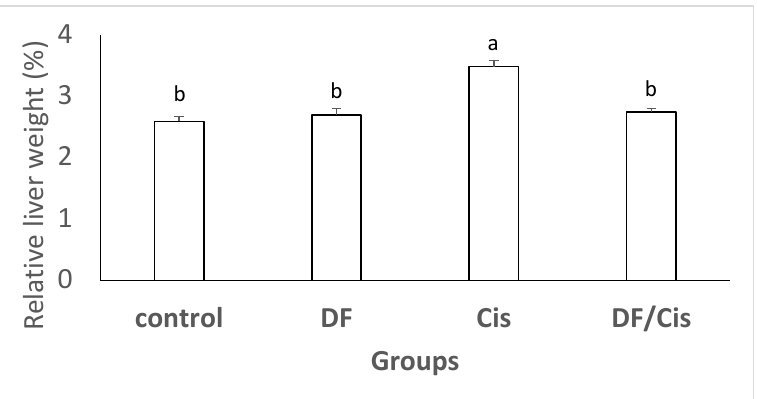
Figure 1. Relative weights of liver of male rats treated with methanolic extract of date flesh (MDFE) and/or cisplatin (Cis). Values are presented as the means ± SE. ( n = 5). Means with different letters (a,b) are significantly different, p ≤ 0.05.